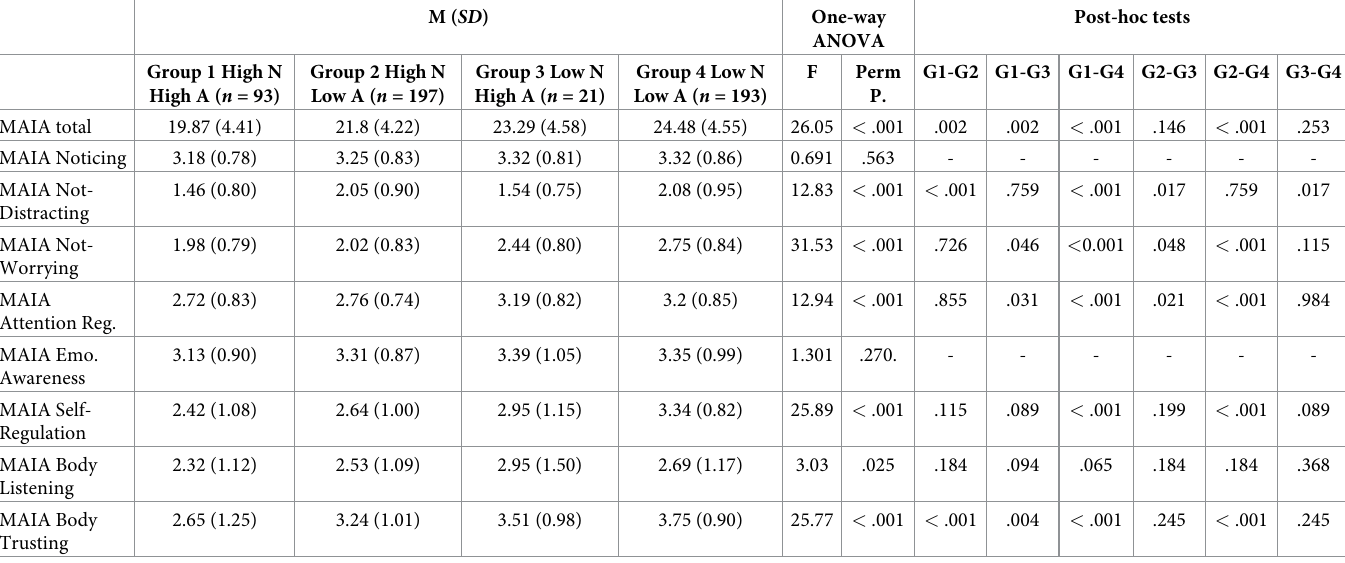
Table 1. Mean (standard deviation in parentheses) values of MAIA total scores and subscores for the four groups with Low/High Alexithymia/Neuroticism. F statis- tics, P value of one-way permutation ANOVAs performed for each variable. P values for post-hoc permutation t-tests are corrected with the Benjamin-Hochberg method. M ( SD )